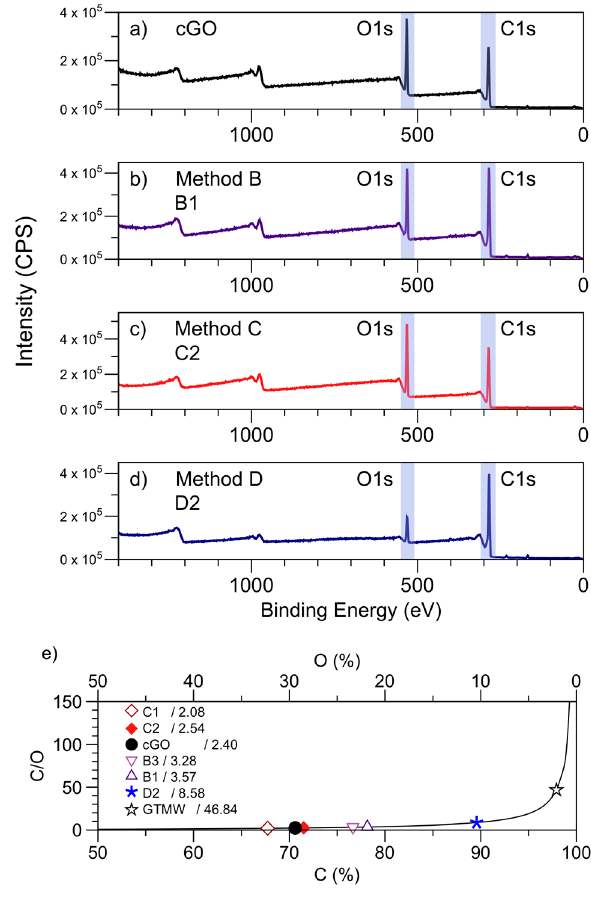
Figure 3. ( a – d ) XPS survey spectrum of each of the methods and ( e ) ratios C/O (surface).